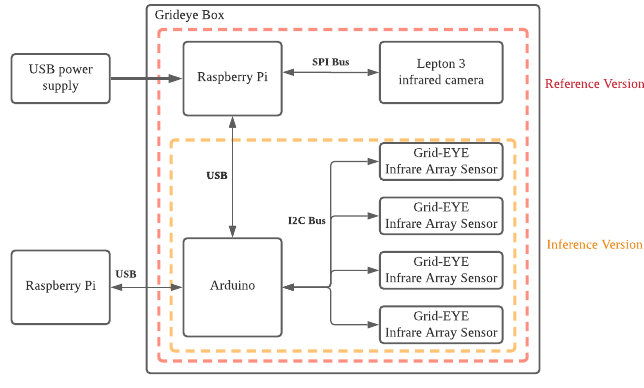
Figure 6. Thermal Box